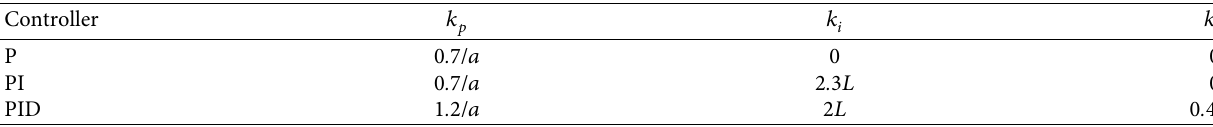
Table 3: The Chien–Hrones–Reswick tuning rules (20% overshoot) [51].